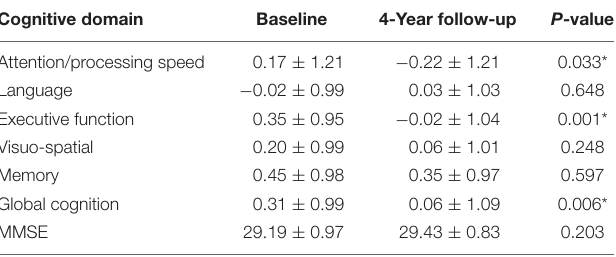
TABLE 1 | Cognitive domain scores.